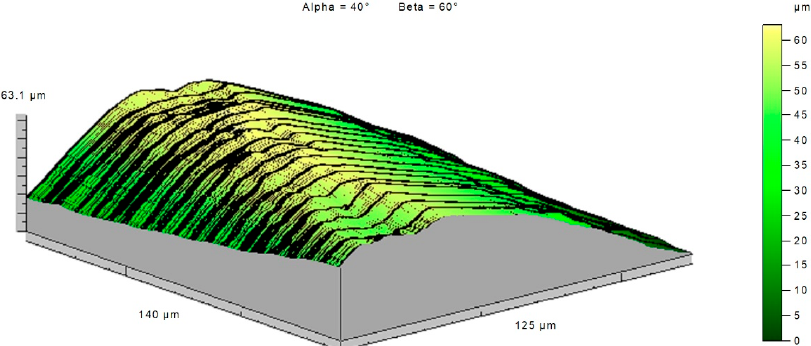
Figure 26. Topography of the cutting edge of a worn insert.